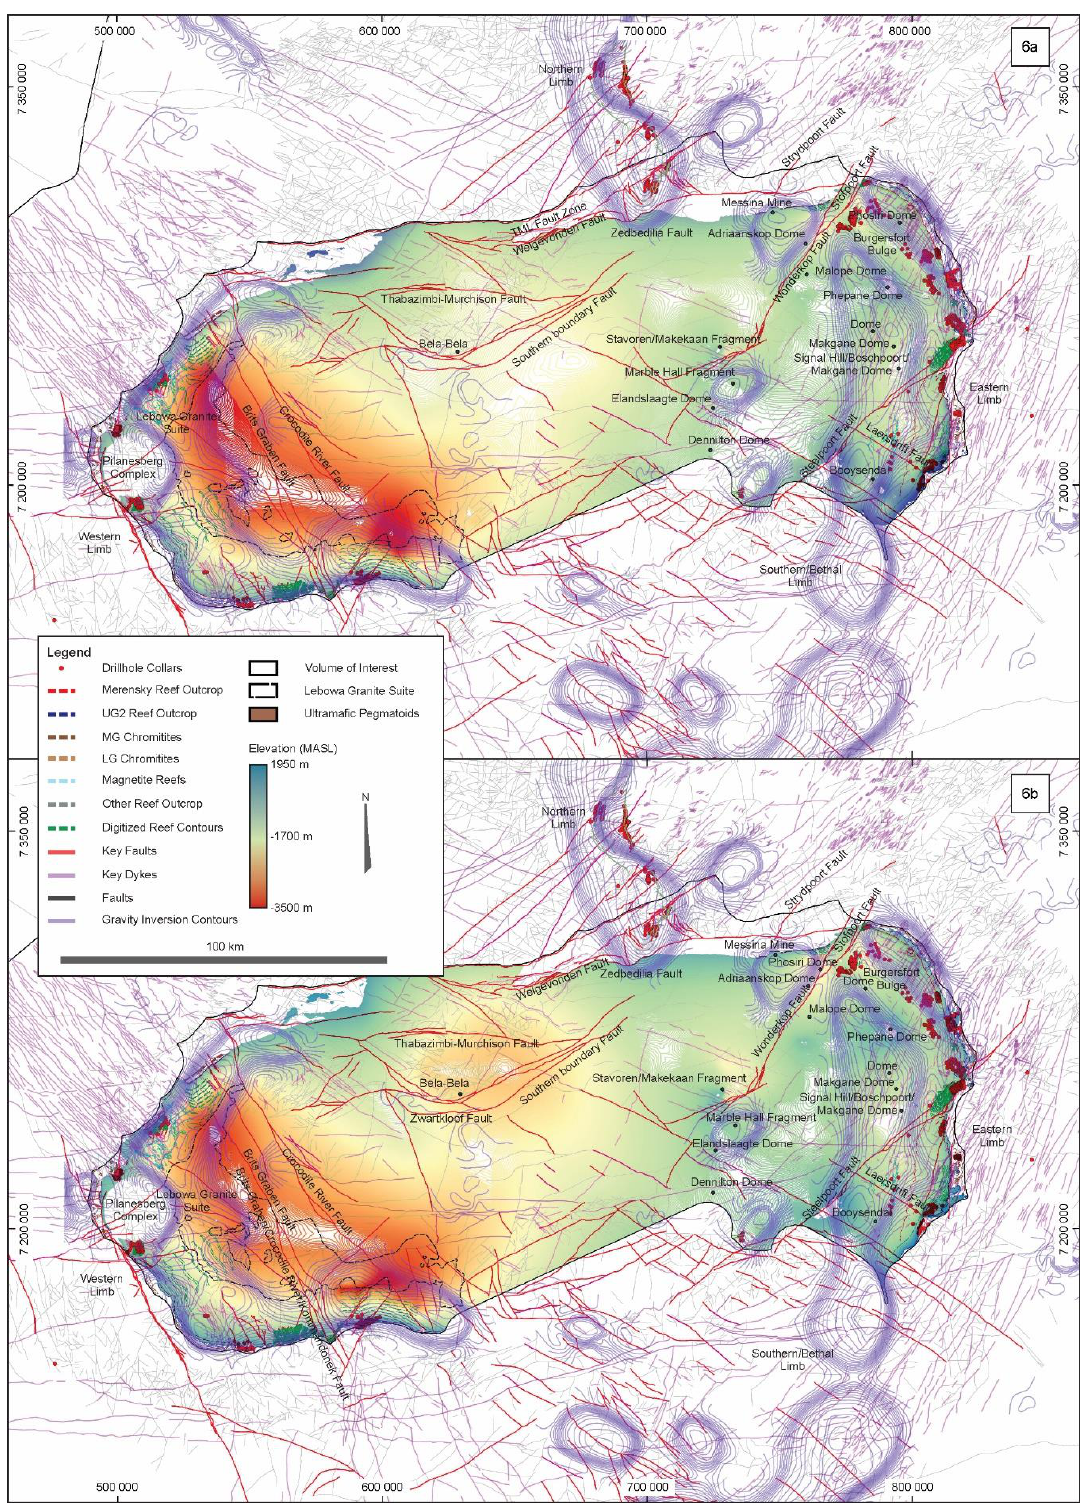
Figure 6. Modelled Merensky ( a ) and UG2 ( b ) elevation contours, in MASL. Modelled UG2 and Merensky Reefs increase in depth (−1700 m MASL) towards the Waterberg Basin, north of Bela-Bela, in an area dominated by faults and thrusts south of the TML, although this increase in depth is more apparent in modelled UG2, possibly suggesting thrust-related splaying.